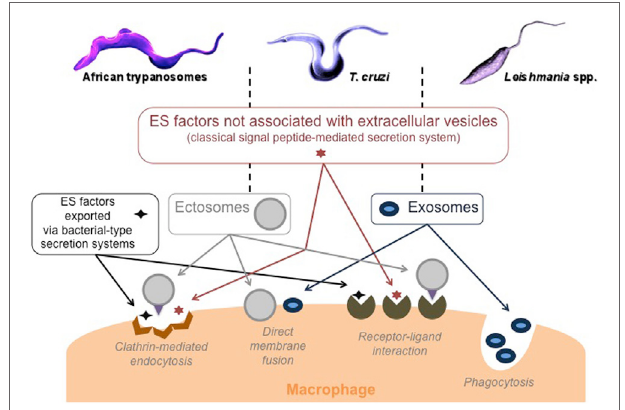
FiGURe 1 | Trypanosomatid modes of secretion and macrophage targeting. ES, excreted–secreted, ectosomes: ubiquitous microvesicles assembled at and released from the plasma membrane, and exosomes: nanovesicles released on the exocytosis of multivesicular bodies.